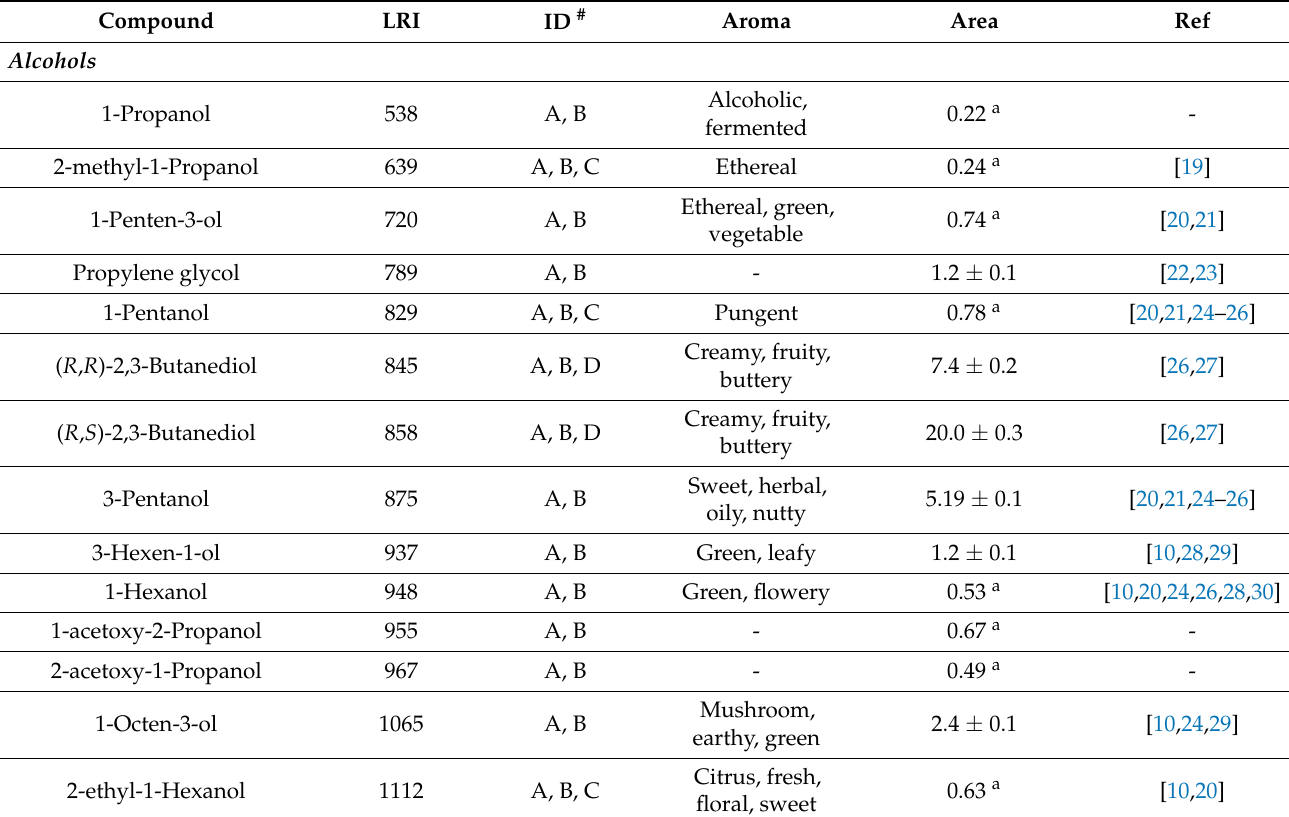
Figure 2. Total ion current chromatogram of VOCs from the M_AI_V_t 0 fibrous sample, obtained using HS-SPME-GC-MS (a.u. = arbitrary units). Table 1. VOC composition of vacuum-freeze-dried melon pomace, at t 0 time (M_AI_V_t 0 ) identified through HS-SPME-GC-MS analysis, grouped by chemical classes. Data are expressed as mean ( n = 3) TIC area × 10 7 ± SD (3) .